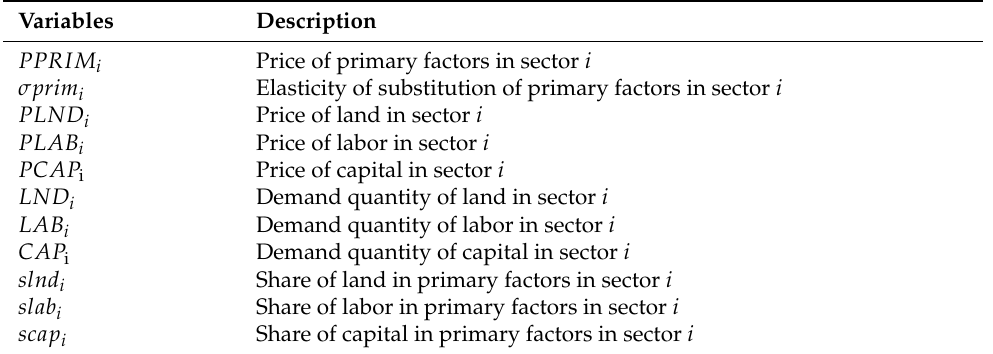
Table A1. Description of variables in equations.